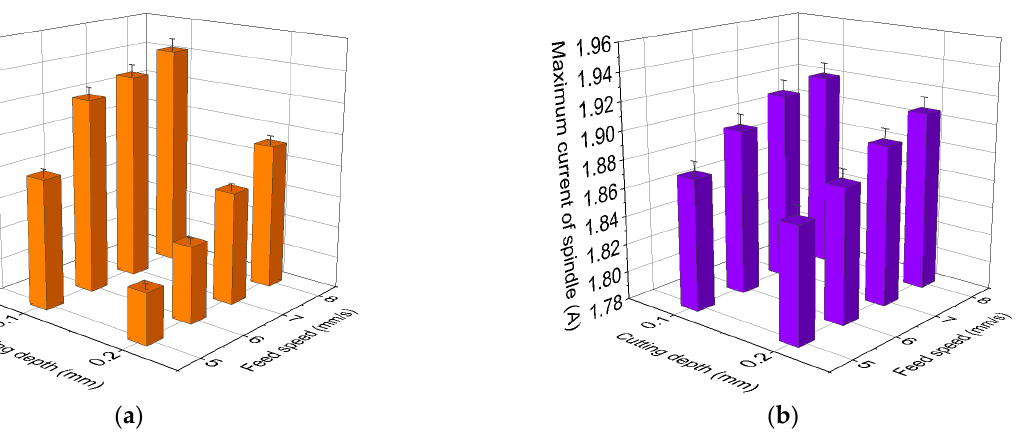
Figure 11. Variation of ( a ) surface roughness Ra and ( b ) maximum current of spindle with cutting depth and feed speed.